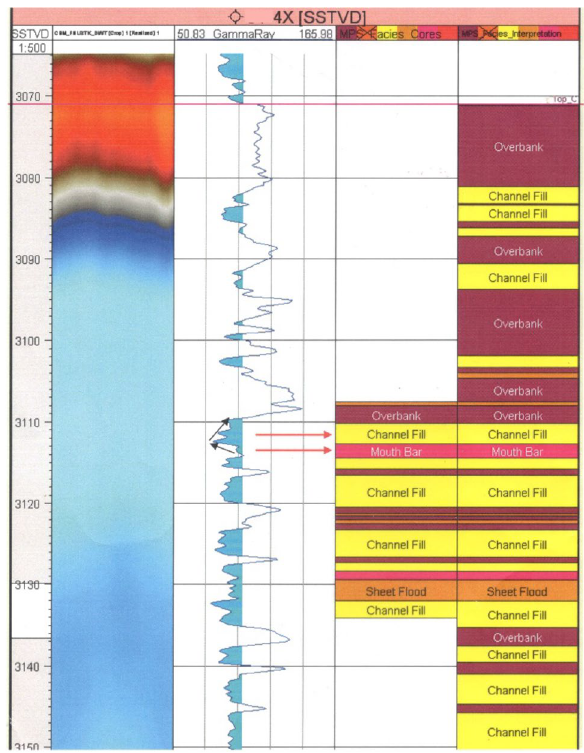
Fig. 7 Comparison in facies interpretation result in 4X based on core data and gamma ray curve